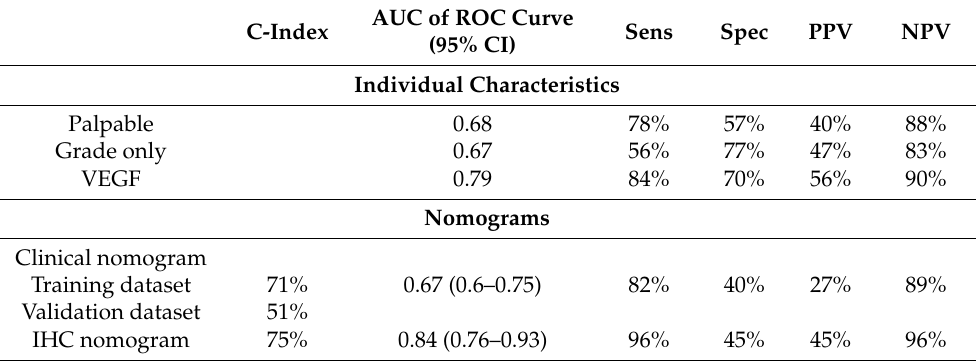
Table 5. Comparison of predictive abilities of individual tumour characteristics were compared with the results of both the clinical and IHC nomograms. AUC of ROC Curve C-Index (95%